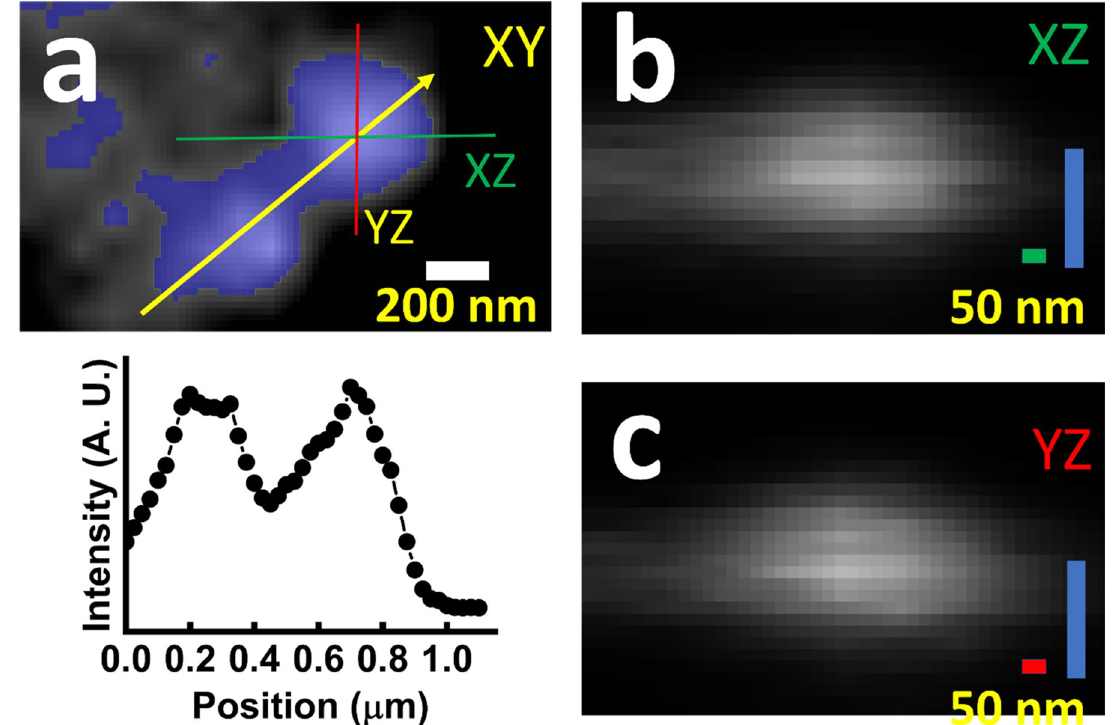
Figure 2. Assessment of the resolution in different directions from a 3D image with two CsBrPb 3 SciNPs. ( a ) Image in the xy plane. An intensity profile along the yellow line is shown below. ( b,c ) The corresponding bright spot in the xz and yz